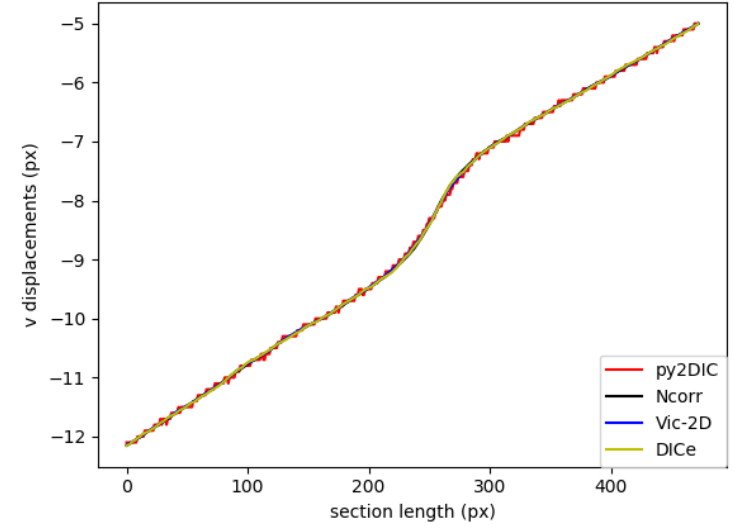
Figure 7. Comparison of v displacement along the section AA among py2DIC , Ncorr , Vic-2D and DICe